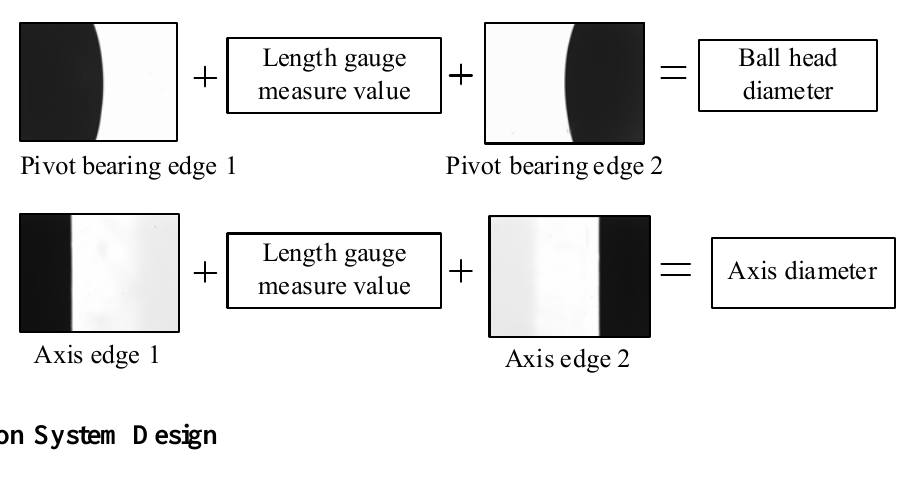
Figure 4. Sketch map of dimensions